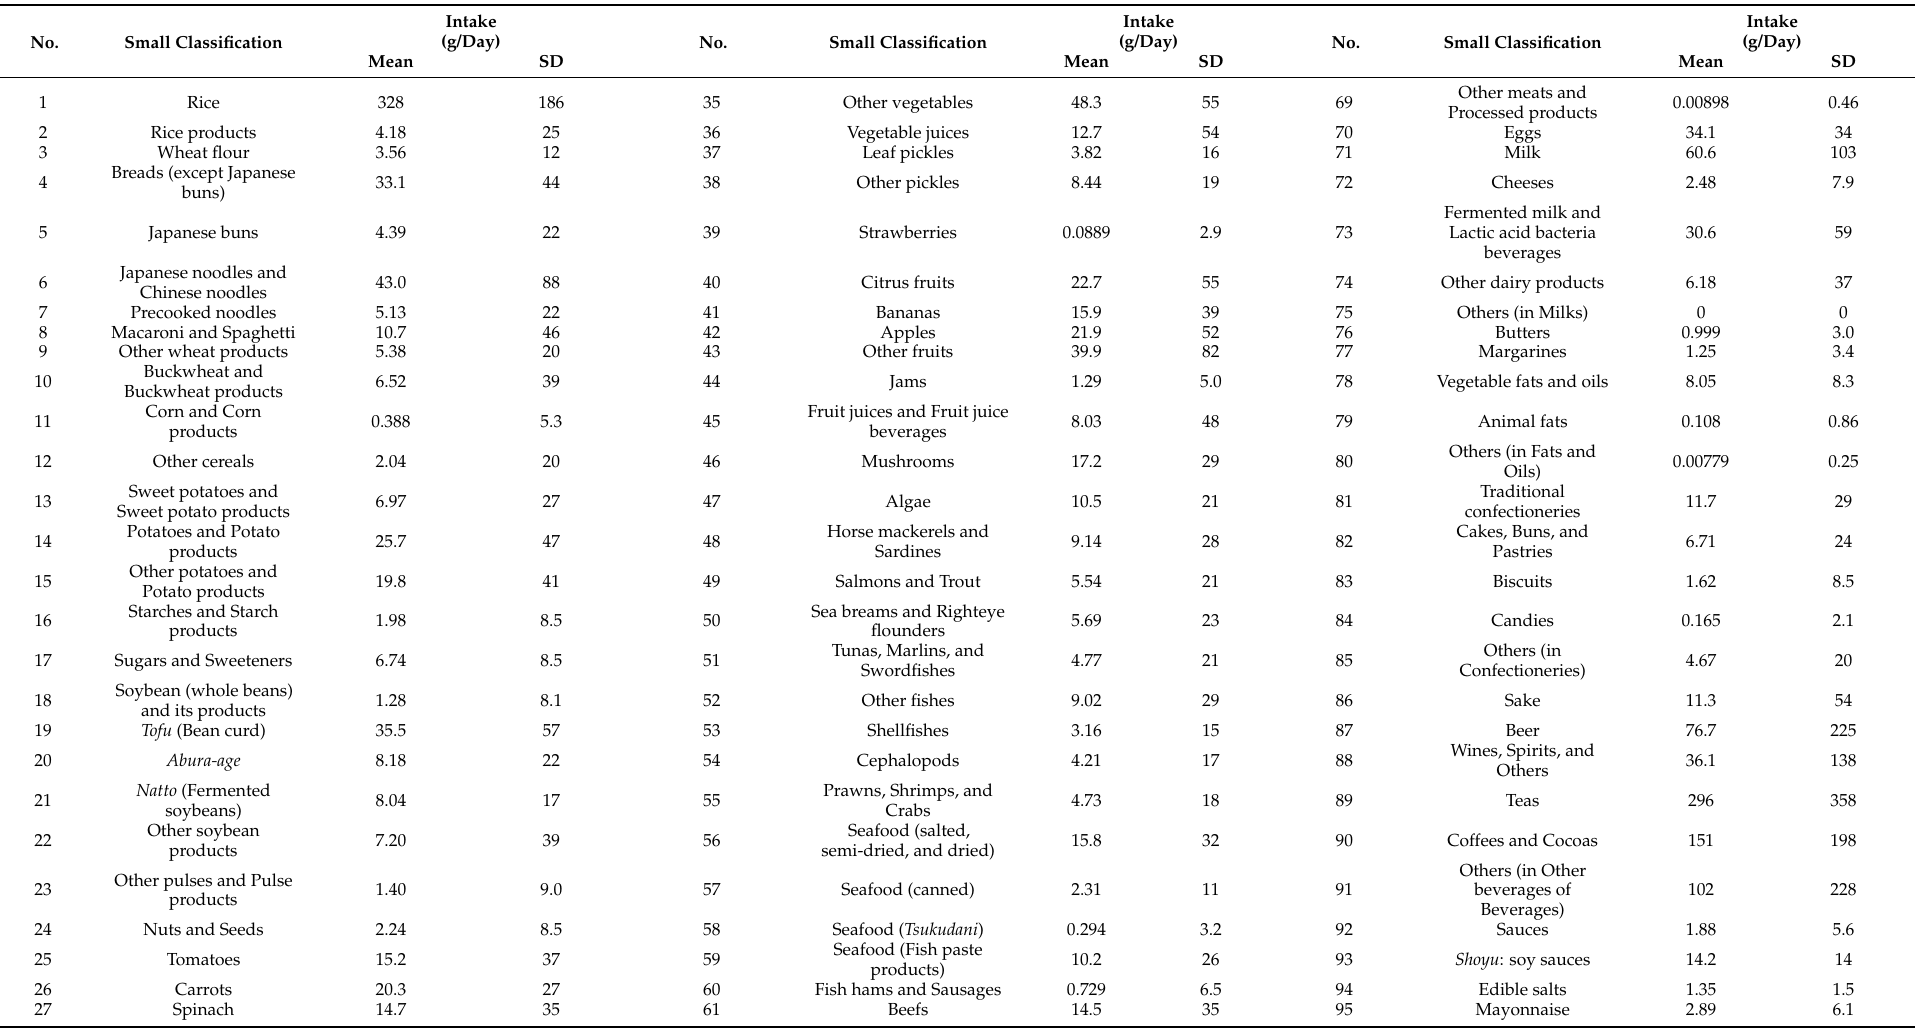
Table 2. The mean value and standard deviation (SD) of food intake in each food category. Numbers 1–98 indicate the number of small classifications in the National Health and Nutrition Survey (NHNS)